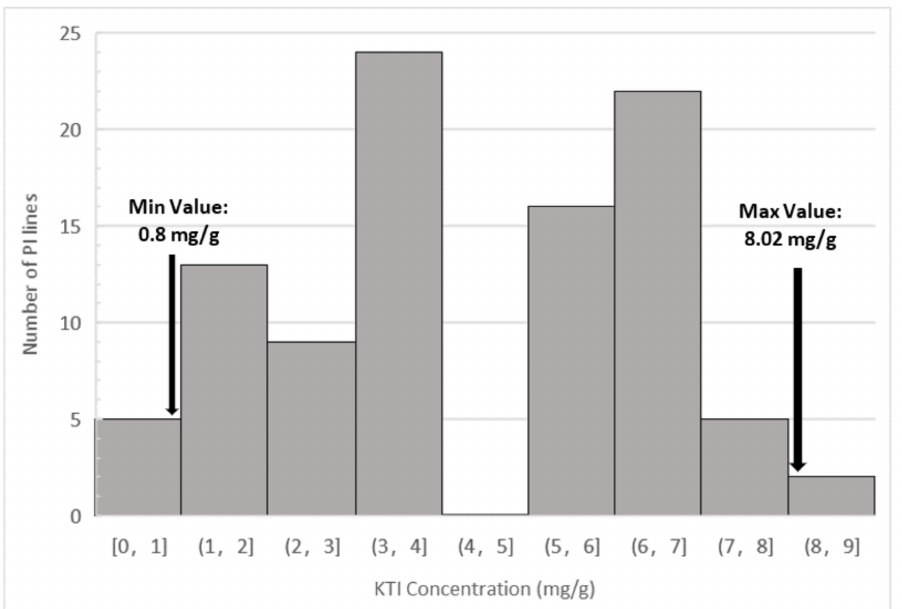
Figure 2. Frequency distribution of KTI concentration (mg/g) of Plant Introductions (PIs) selected for the SNP